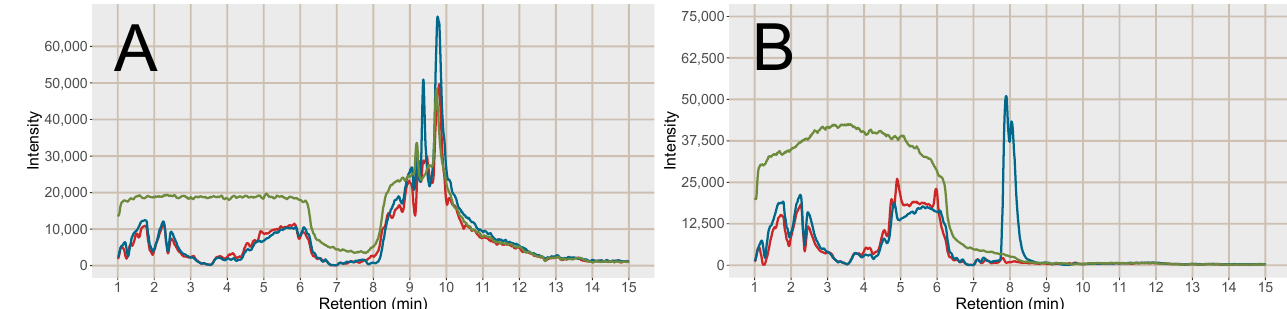
Figure 5. Post-column infusion chromatograms of tryptophan (5*D) Na + /K + adducts, ( A ) [M+2K − H] + and ( B ) [M+2Na − H] + . Red line = injection of blood plasma sample prepared with SPE MCX, blue line = injection of blood plasma sample prepared with PPT and green line = injection of a solvent blank. Each line is based on the average of 3 samples of each type, PPT, SPE MCX or